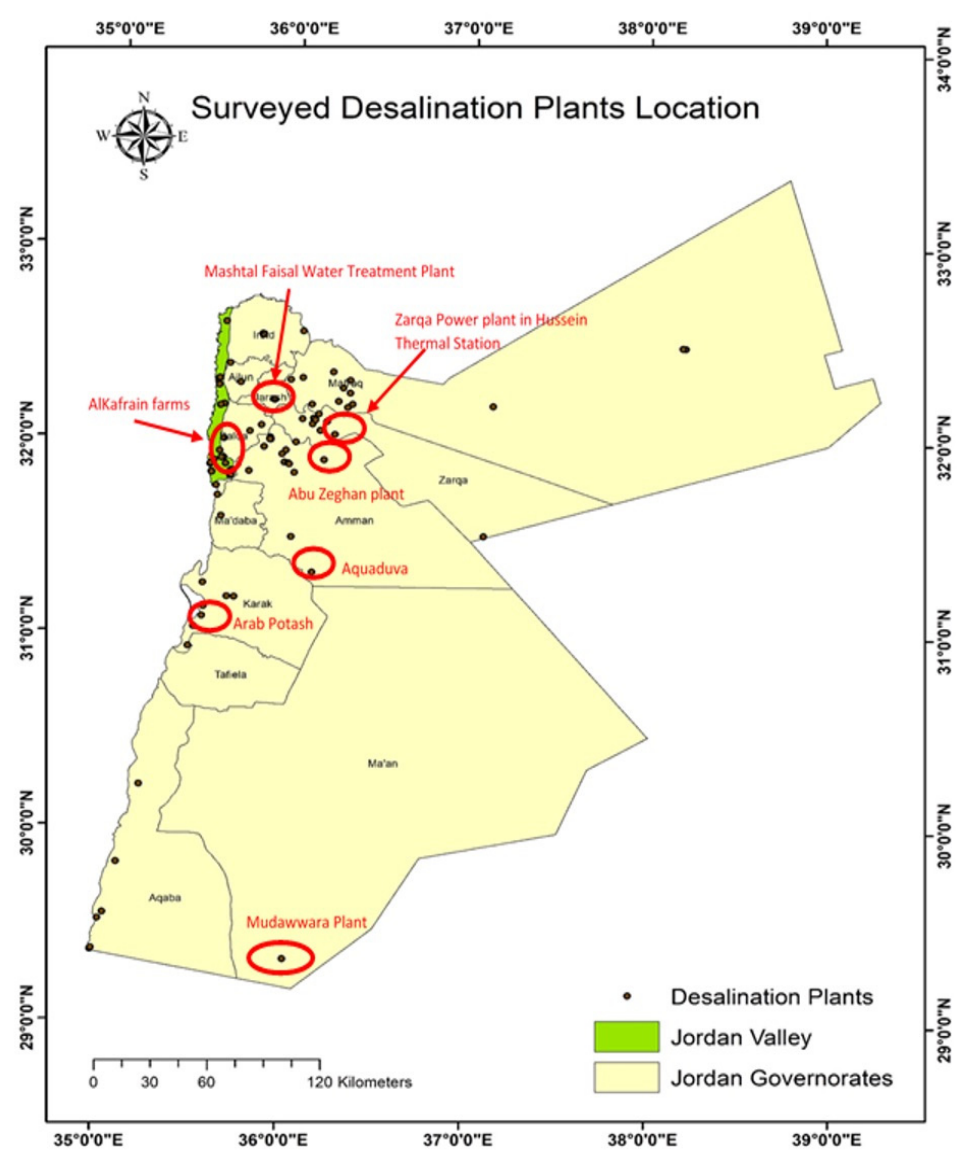
Figure 3. Locations of the Surveyed BWRO Desalination Plants.